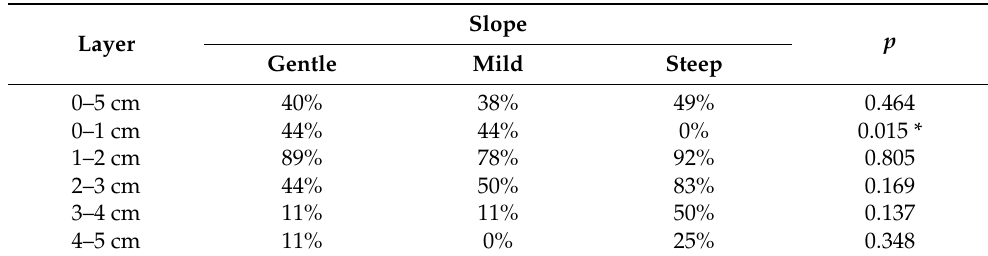
Table 3. Proportion of hydrophobic class of MED test by soil depths and the results of Fisher’s exact test on slope gradient.